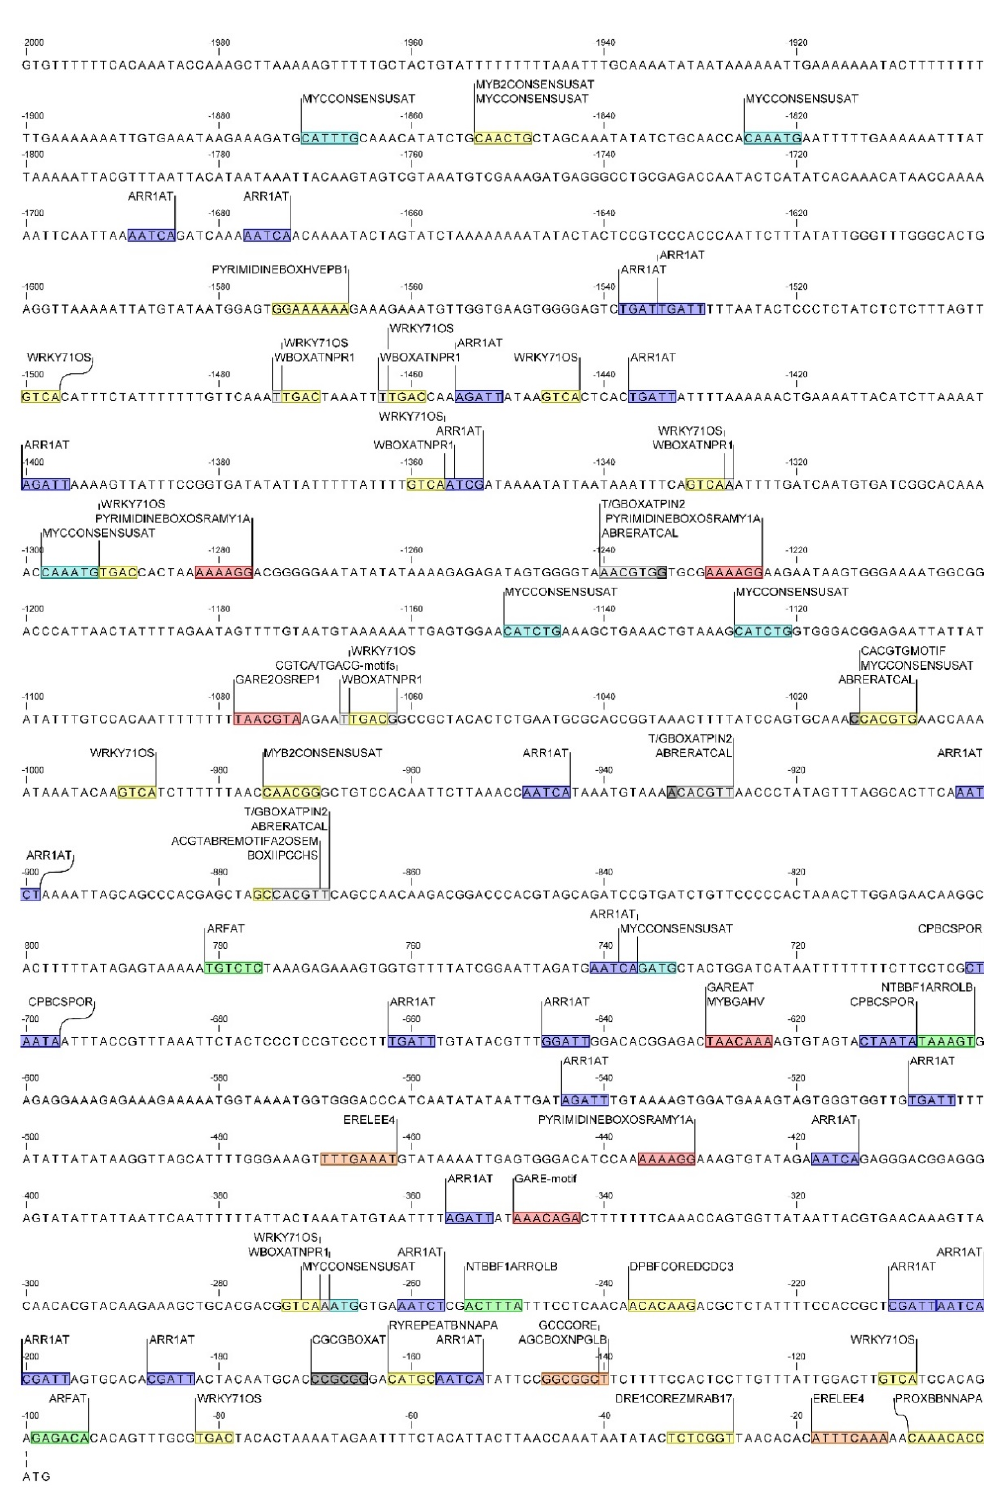
Figure 9. Location of cis -regulatory elements within the DcAOX2a promoter’s, involved in cold- stress response (in light blue), in response to plant hormones: auxin (green), cytokinin (dark blue), abscisic acid (yellow), gibberellin (red), ethylene (orange), and calcium (grey).